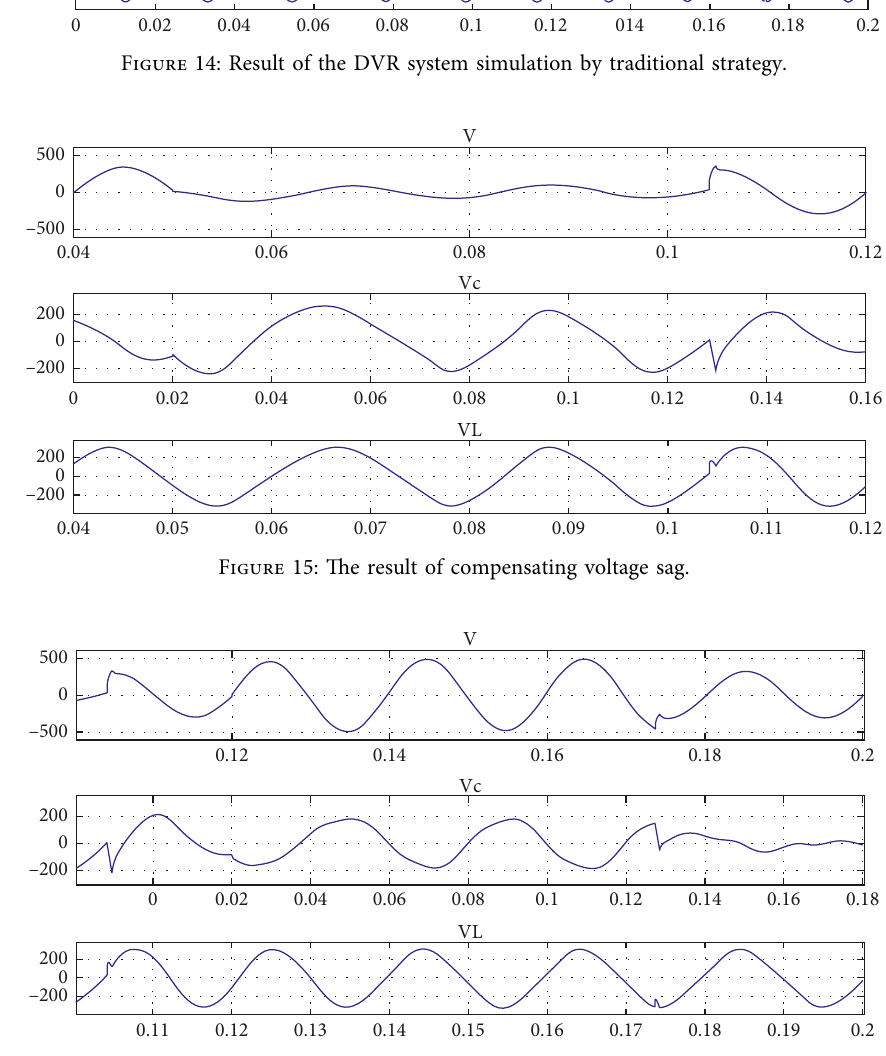
Figure 16: The result of compensating voltage